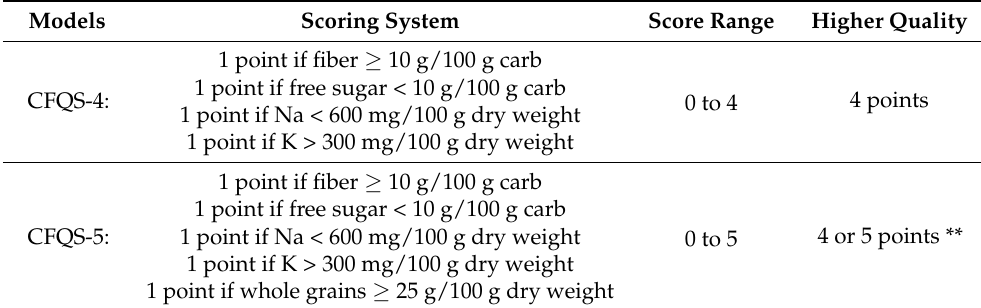
Table 2. The Carbohydrate Food Quality Scoring System for CFQS-4 and CFQS-5 Models.